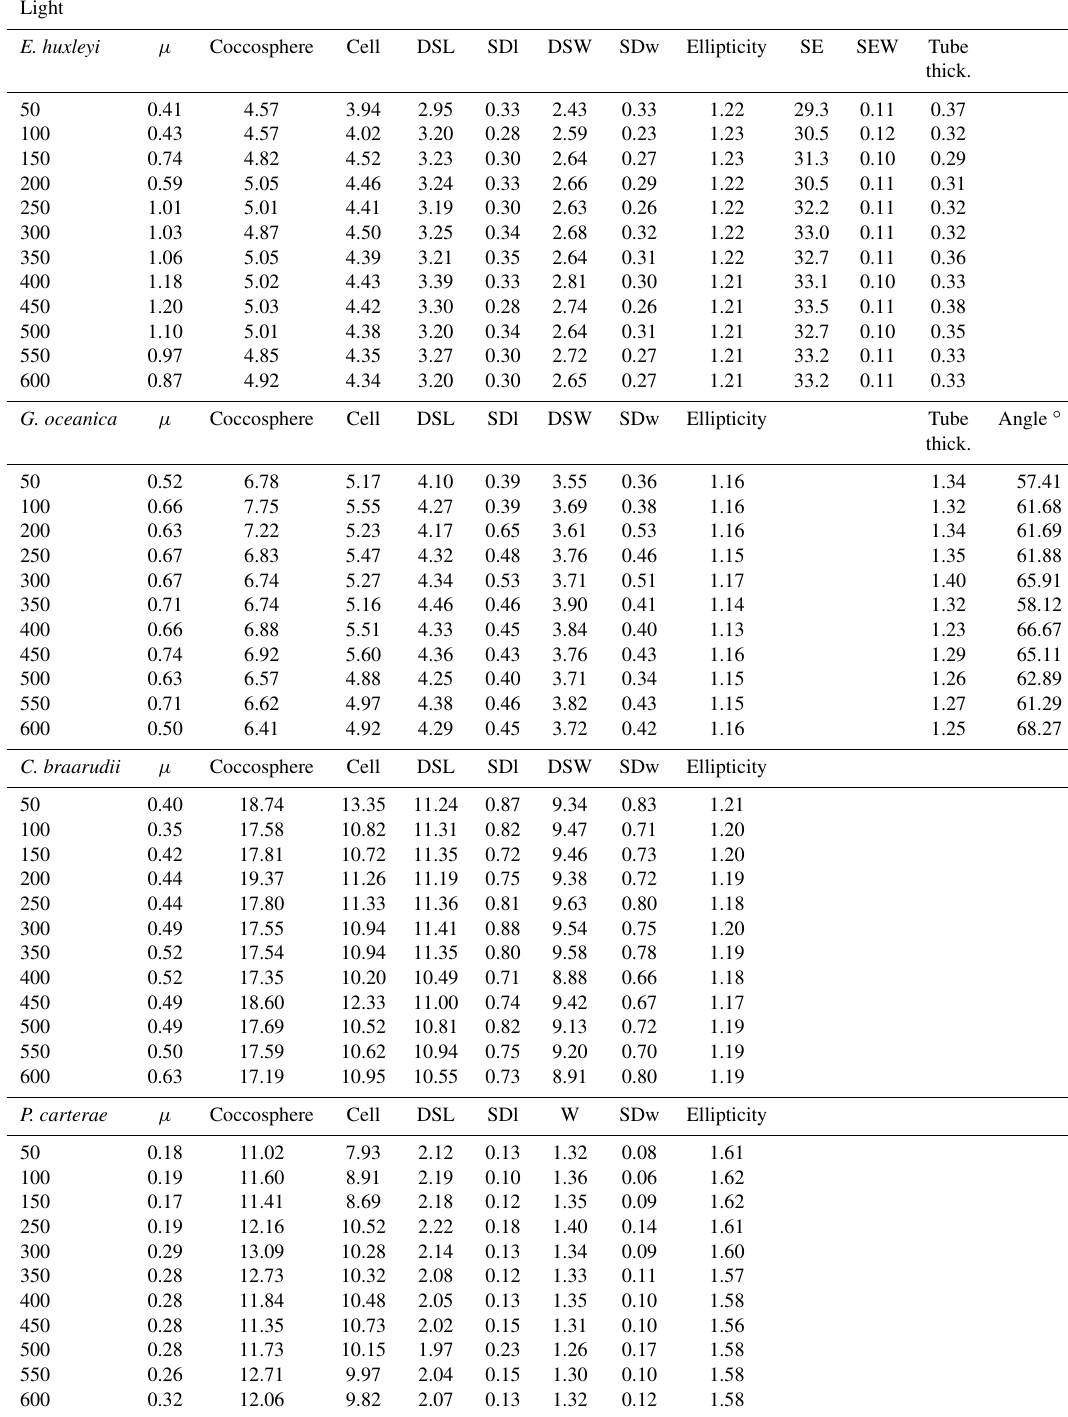
Table 2. Light experiments data. Growth rate ( µ , in cellsd − 1 ); coccosphere and cell diameters (in µm); coccolith morphometric analyses were performed on 50 specimens for every treatment for the following: average of coccolith distal shield length (DSL; in µm) and coccolith distal shield width (DSW; in µm); ellipticity (DSL/DSW); average E. huxleyi distal shield elements number (SE) and average distal shield elements width (in µm; SEW); average E. huxleyi inner tube thickness (in µm; tube thick.); G. oceanica tube thickness (in µm; tube thick.); G. oceanica bridge angle (angle ◦ ). For G. oceanica and P. carterae , data from 150 and 200µmolphotonsm − 2 s − 1 are missing due to errors in light intensity inside the light cabinet; SD: standard deviation. SDl and SDw refer to DSL and DSW standard